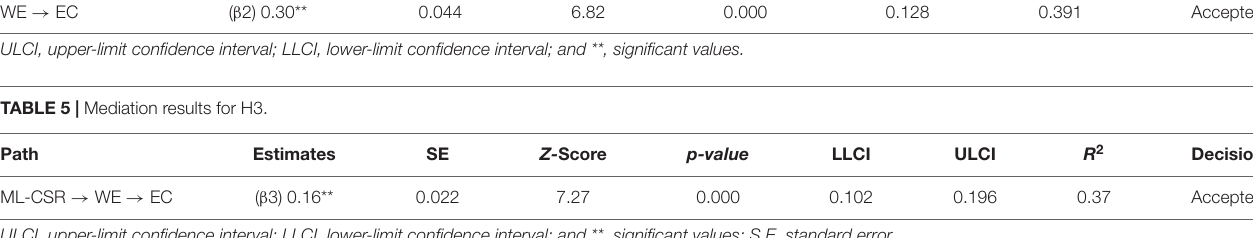
Table 4 . As per the finding of the direct effect model, there was a significant effect of ML-CSR on WE and EC ( β 1 = 0.31, β 2 = 0.38, p < 0.05) as indicated by their respective beta values and p- values. Thus, based upon the statistical pieces of evidence, it is established that both hypotheses (H1 and H2) of the current analysis are found to be significant, and H1 and H2 are therefore accepted. Moreover, the model fit values were also significant ( χ 2 = 3814.281, df = 847, p < 0.01 χ 2 / df = 4.50, RMSEA = 0.052, CFI = 0.936, NFI = 0.913).